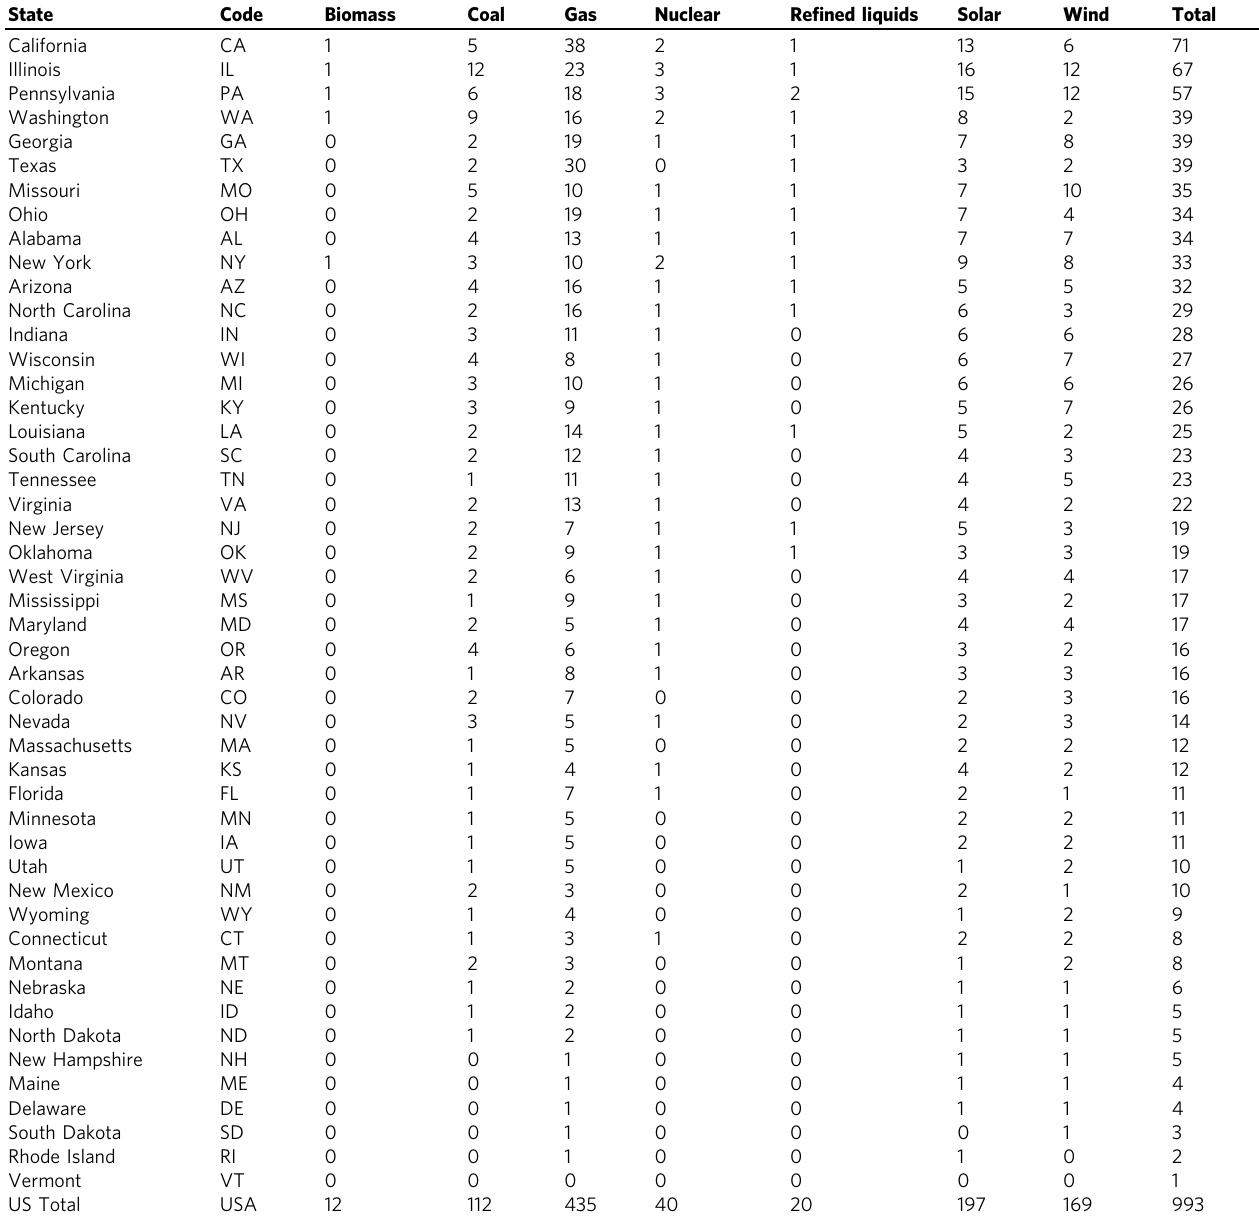
Table 1 Temperature-induced increases in cumulative capital investments (2015 – 2100; billion USD) by state and fuel.